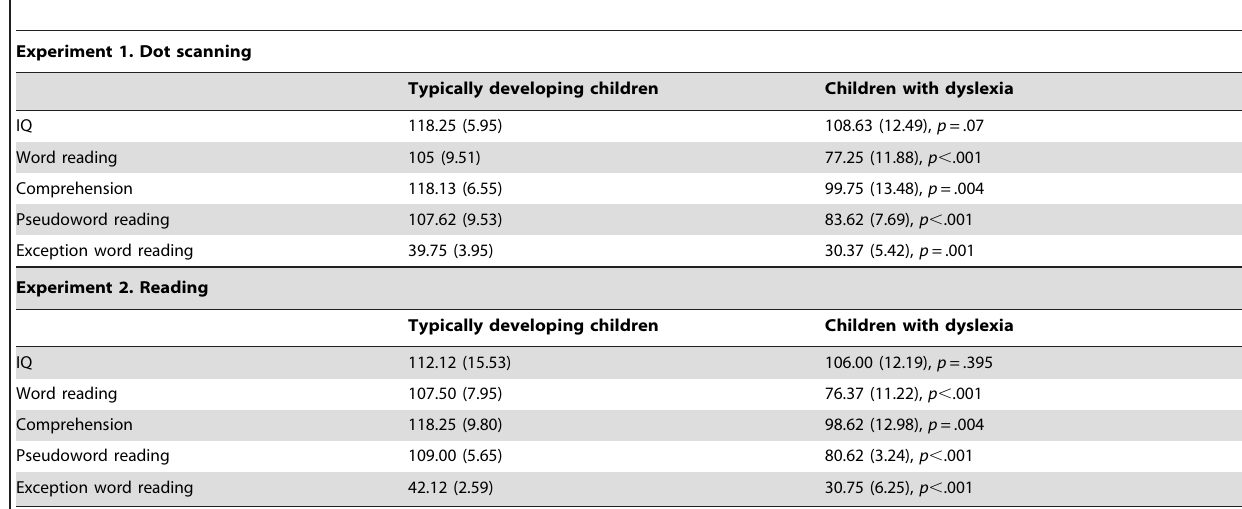
Table 5. Means (SD in parentheses) for the WASI IQ test, WIAT reading tests, and exception word reading: all t-tests were two-